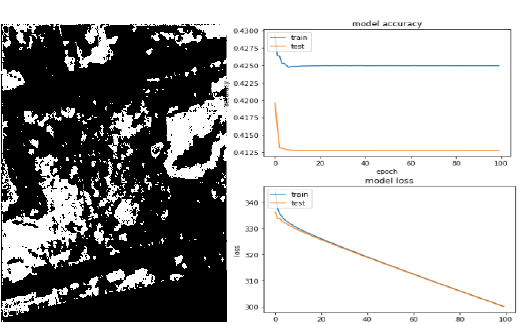
Figure 13 . Test 5 predictions: segmented image,